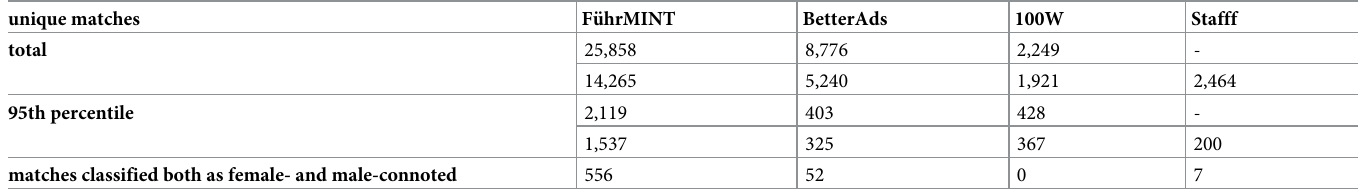
Table 5. Total number and 95th percentile of unique matches per technology and data sample. Second row represents smaller data sample. We consider words falling under 95th percentile in order to exclude rare and misspelled words. unique